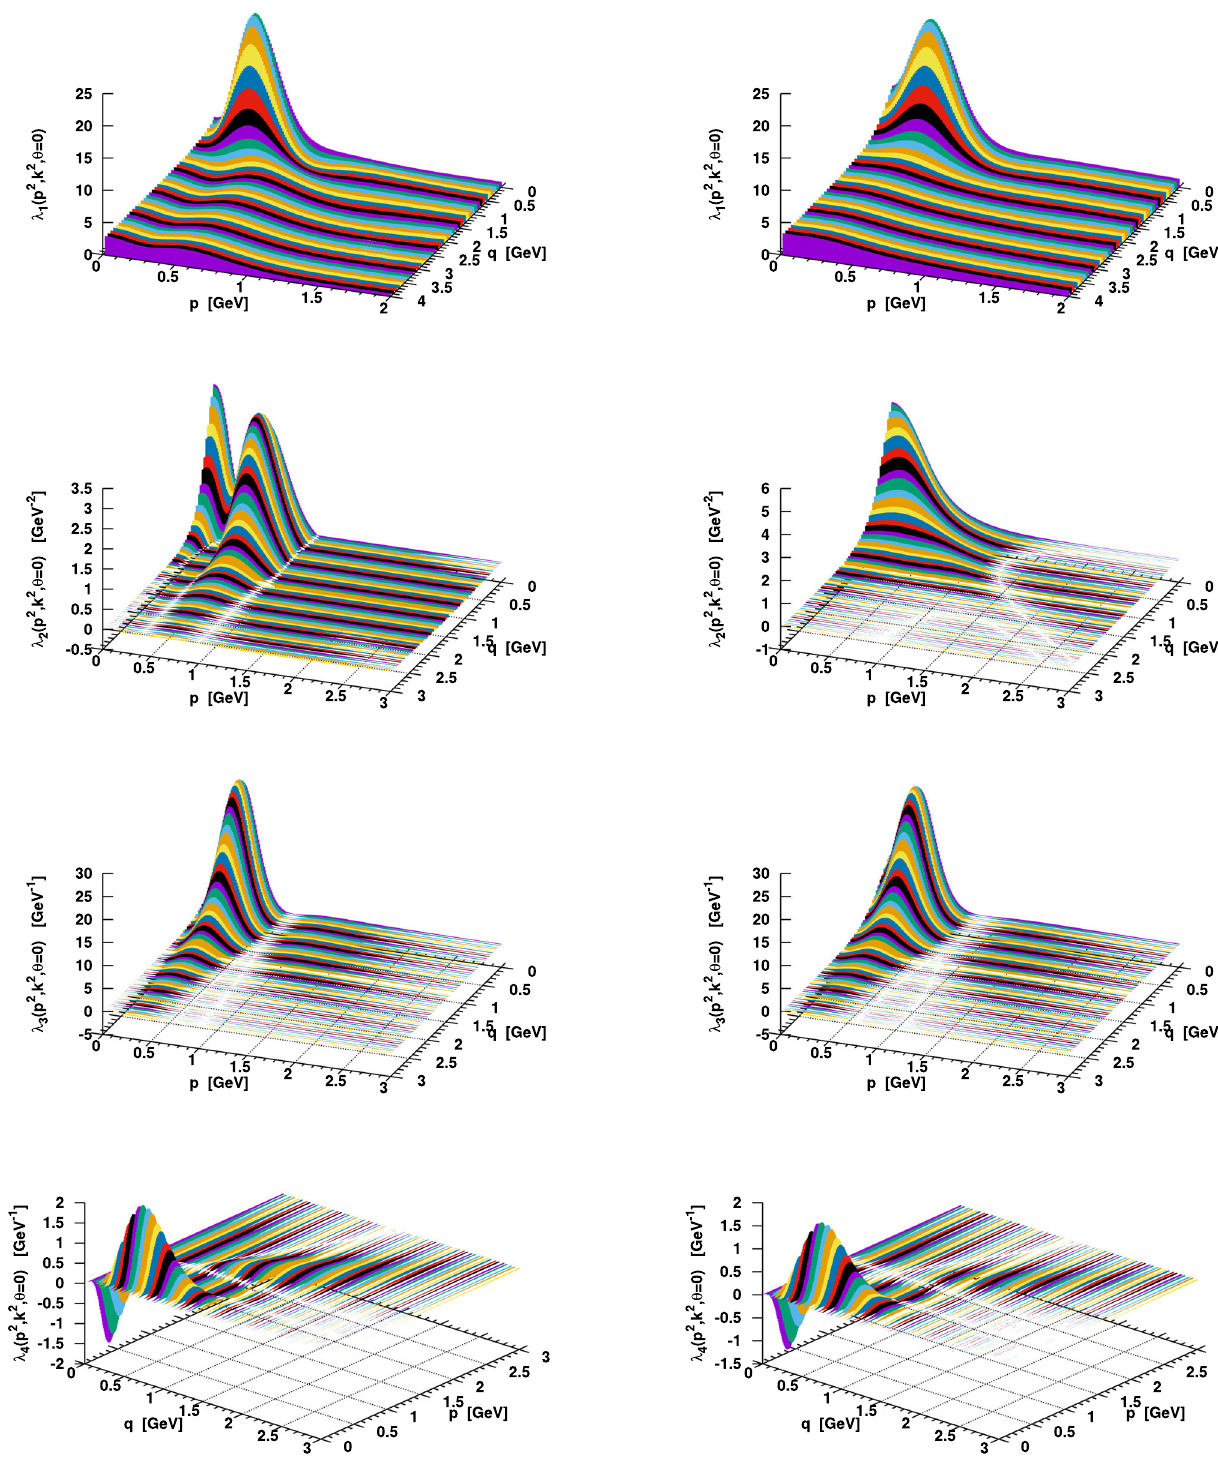
Fig. 5 Form factors for Sol. I reported in [4] (left) together with those associated with the new solution based on Padé approximantions